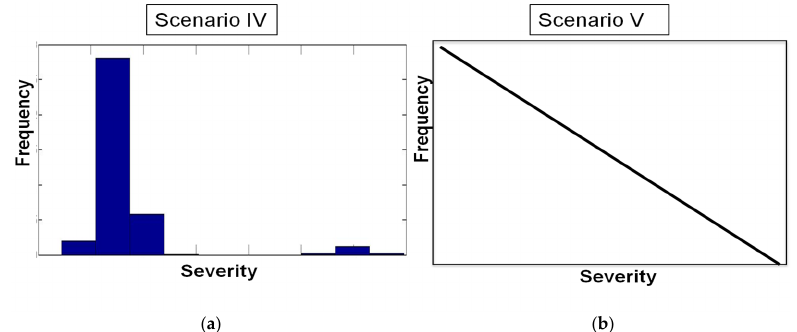
Figure 3. Visualization of the loss frequency and loss severity relationship in Scenarios (IV) and (V): ( a ) Left panel shows Scenario (IV) splitting high/low severity mixture → high/ low frequency. This case corresponds to the two ‐ regime mixture as described in Section 3.1; ( b ) The right panel shows Scenario (V), in which a linear relationship exists between frequency and severity. Scenario (IV) represents a mixture relationship between frequency and severity. Scenario (V) depicts a linear functional dependency between frequency and severity.